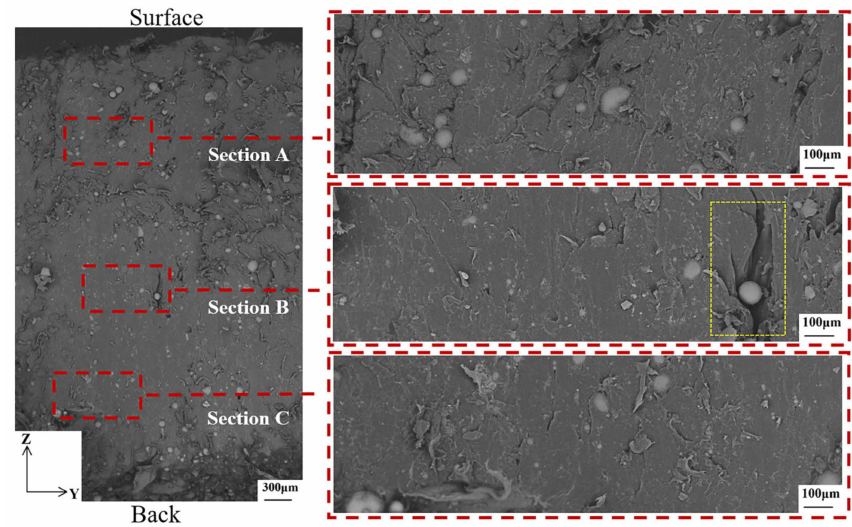
Figure 10. Microscopic morphology of the motor before ablation in the ZOY direction.